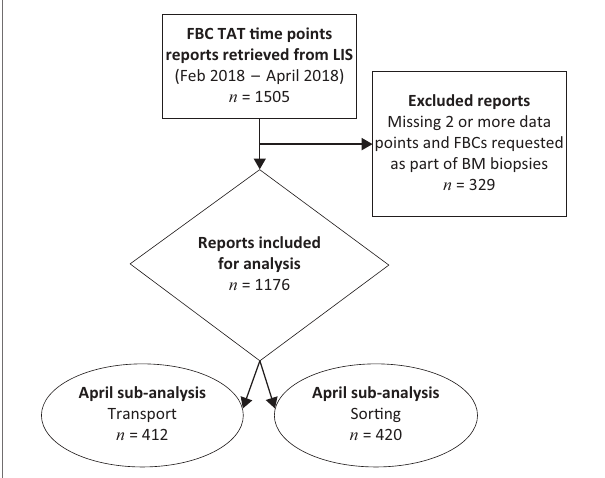
FBC TAT (cid:25)me points reports retrieved from LIS (Feb 2018 – April 2018) n =